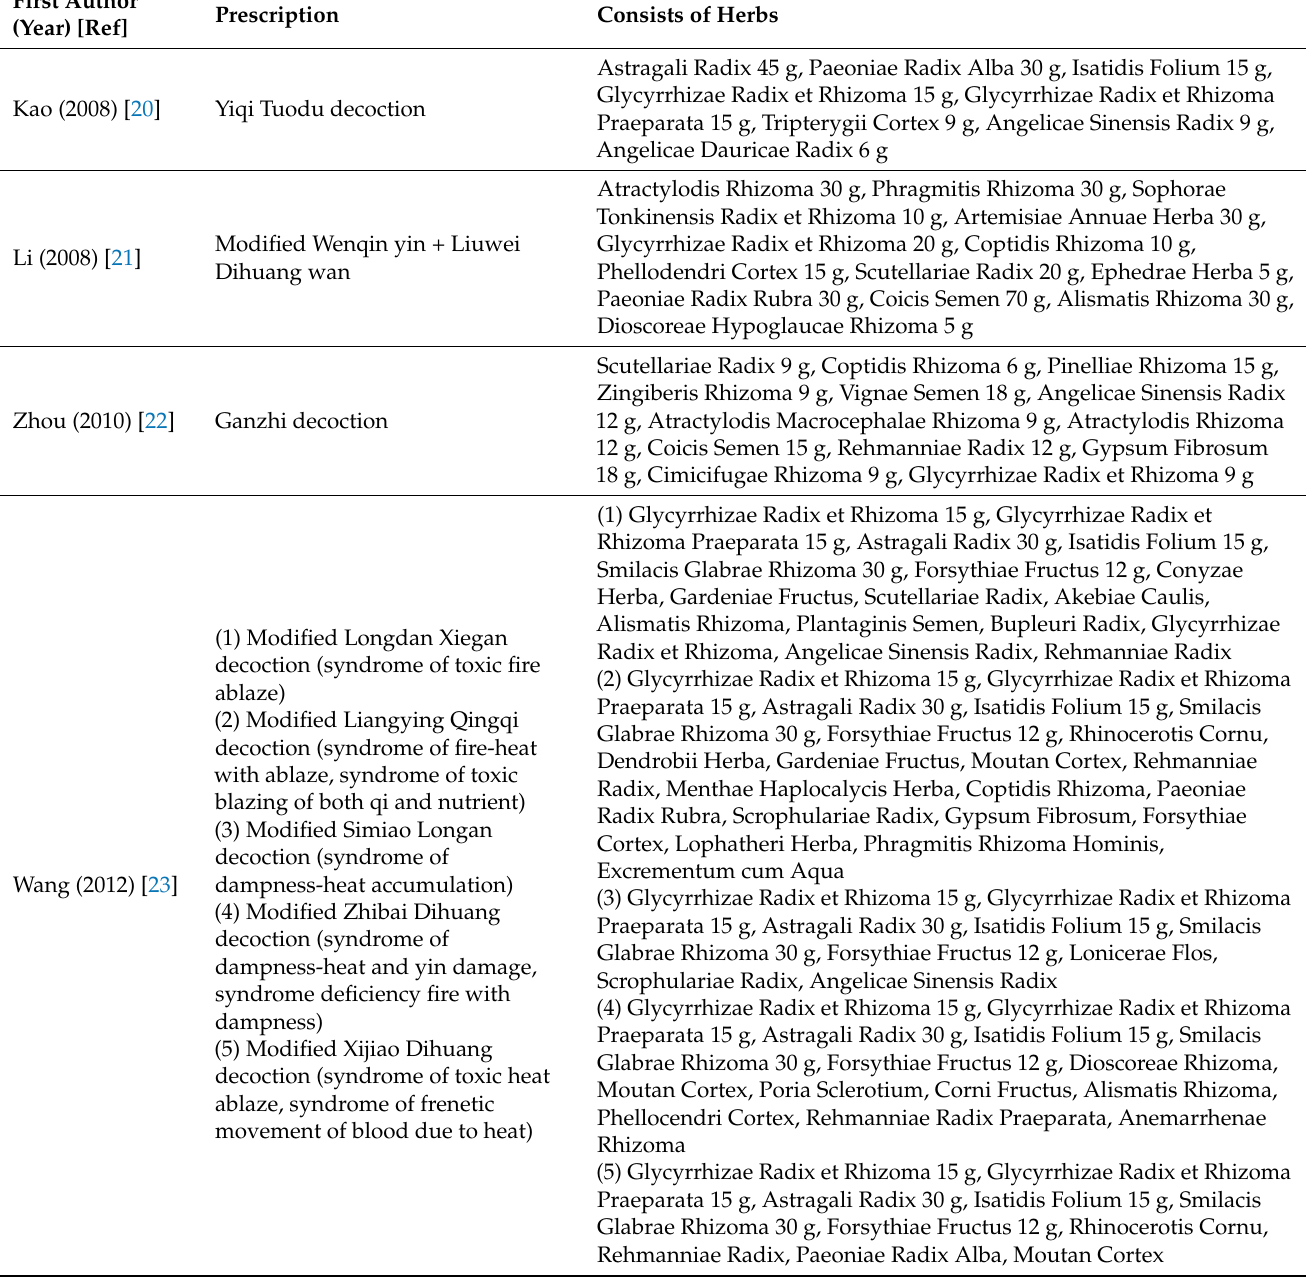
Table 2. Composition of the herbal medicines for Behçet’s